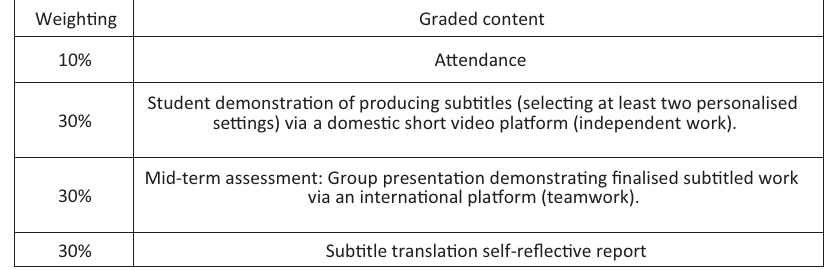
Fig. 5 Marking criteria of the course in Chinese and its English translation. The detailed assessment in Chinese of the online course Consecutive Interpreting by Guangdong University of Foreign Studies and its English